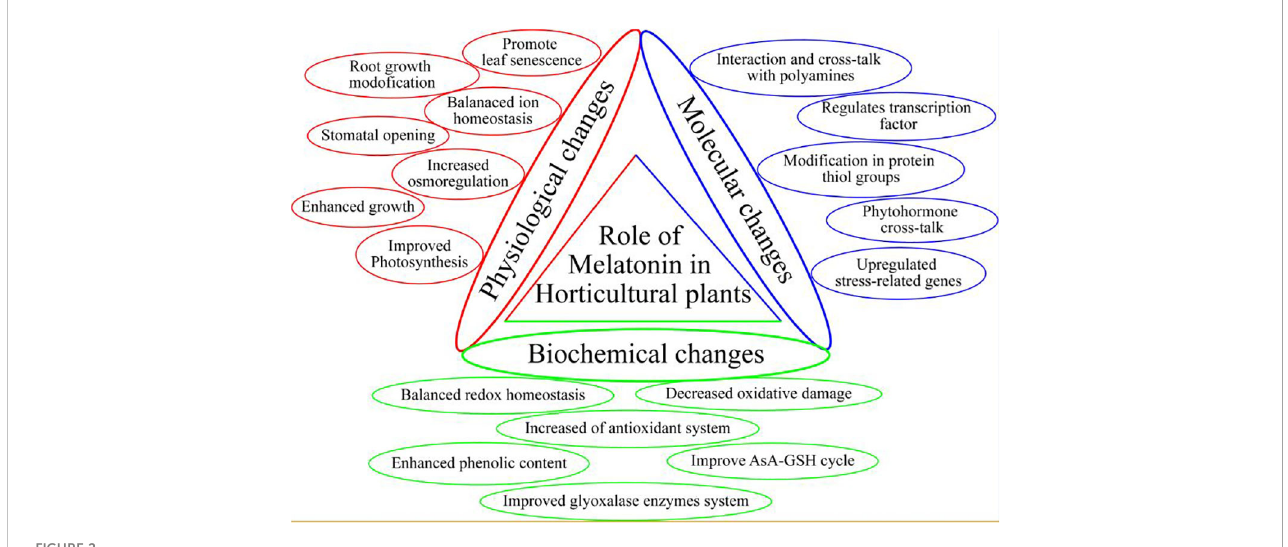
FIGURE 2 Role of melatonin in horticultural plants.